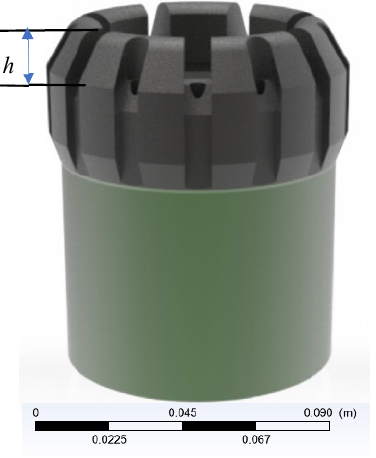
Figure 2. Bit model diagram.